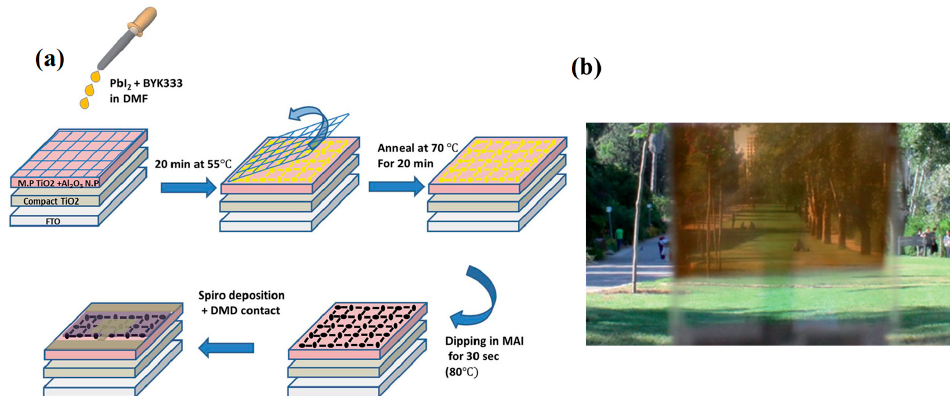
Figure 3. ( a ) A two-step deposition process used to create a semitransparent perovskite solar cell. The PbI 2 grid is first created and annealed, after which the entire electrode is submerged in the MAI solution to create the MAPbI 3 grid. The hole transport material (HTM) layer is covered with an evaporated dielectric-metal-dielectric contact during the final stage. ( b ) Semitransparent device. [83].